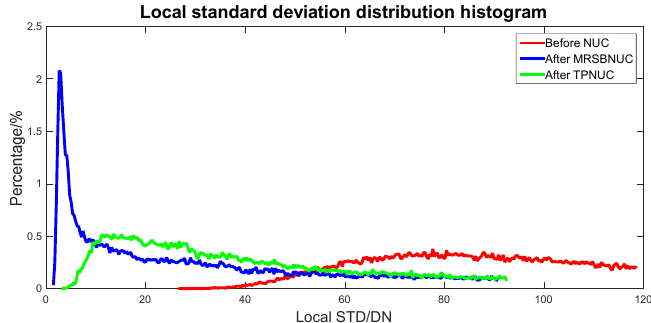
Figure 14. Local standard deviation distribution of sky scene with clouds: before NUC, after TPNUC, and after MRSBNUC.